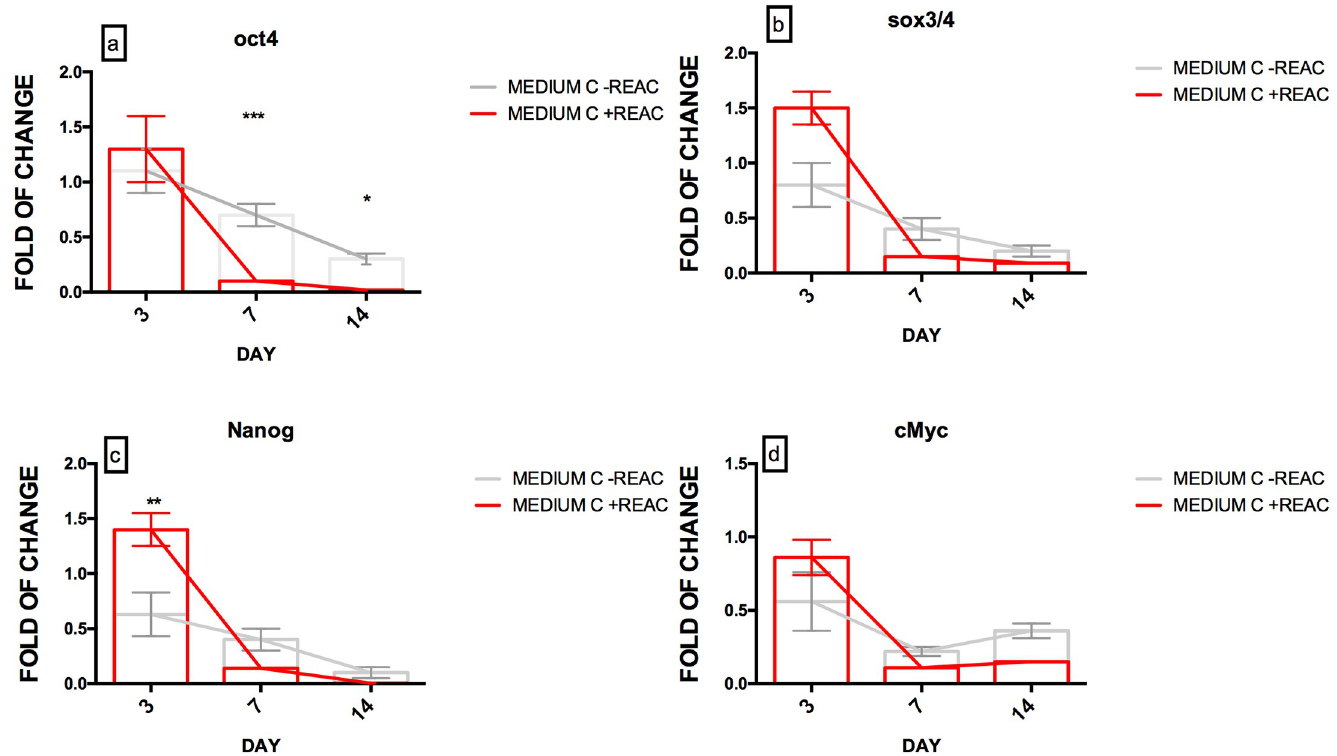
Fig 2. Effect of REAC treatment on the expression of pluripotency genes in hUiPSCs supplemented with defined medium. Cells cultured in cardiogenic conditioned medium (Medium C) were exposed for 72 h, in the absence (grey bars) or presence (red bars) of REAC and then cultured in the presence of medium C alone until day 14th. The amount of OCT4(A), SOX3/4 (B), NANOG (C) and cMyc (D) mRNA from untreated (grey bars) or REAC-treated (red bars) cells was normalized to glyceraldehyde 3-phosphate dehydrogenase (GAPDH) and was plotted as fold of change relative to the mRNA expression in hUiPSCs at day 0. Data shown mean ± S.D; n = 4 (P < 0.05 �� ), (P < 0.001 � �� ).